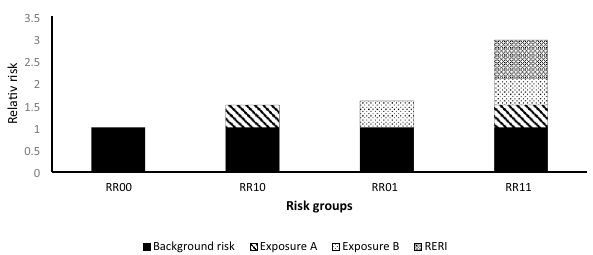
Figure 2. An illustration of additive interaction between Exposures A and B. RR 00 represents the relative risk among those not exposed to A and B (also known as the background risk), RR 10 represents the relative risk among those exposed to A only, RR01 represents the relative risk among those exposed to B only, RR11 represents the relative risk when exposed to both A and B, RR11 may additionally contain the relative excess risk of interaction (RERI), which is the excess risk that only occurs when exposure A interacts with exposure B